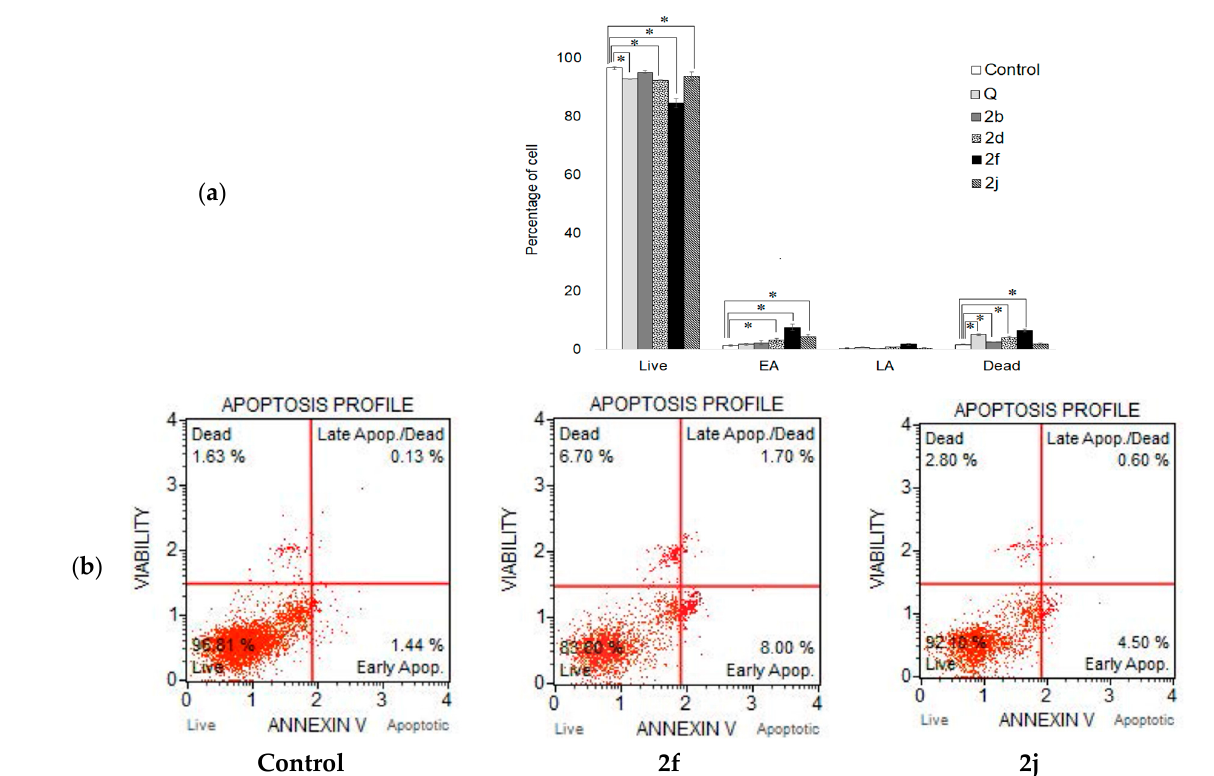
Figure 5. Cells were treated with control (medium) and samples with IC 50 : quercetin, 2b , 2d , 2f , and 2j . The bars represent the ratios of the apoptotic cells in each group. Data from each cell cycle phase are expressed as means ± SD deviation of three independent experiments. * p < 0.05 vs. control group for each phase. The p values were calculated using a one-way ANOVA with Tukey’s HSD multiple comparison post hoc analysis ( a ). The apoptotic effect of synthesized compounds, 2f and 2j, incubated for 24 h in HeLa cells ( b ).